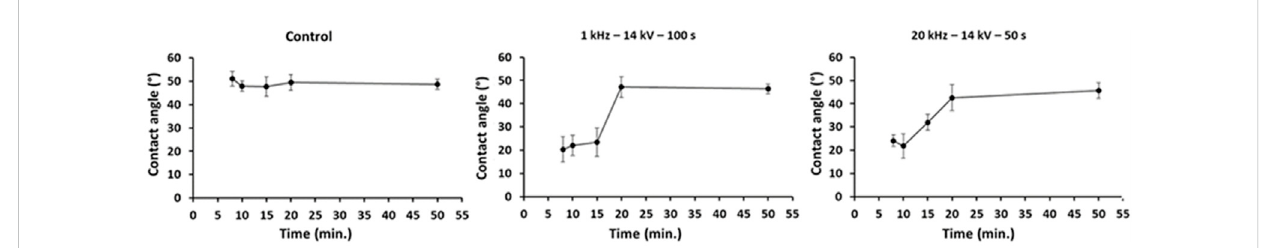
FIGURE 7 Evolution of the water contact angle for left: control, middle: 1k100s, and right: 20k50s exposures.